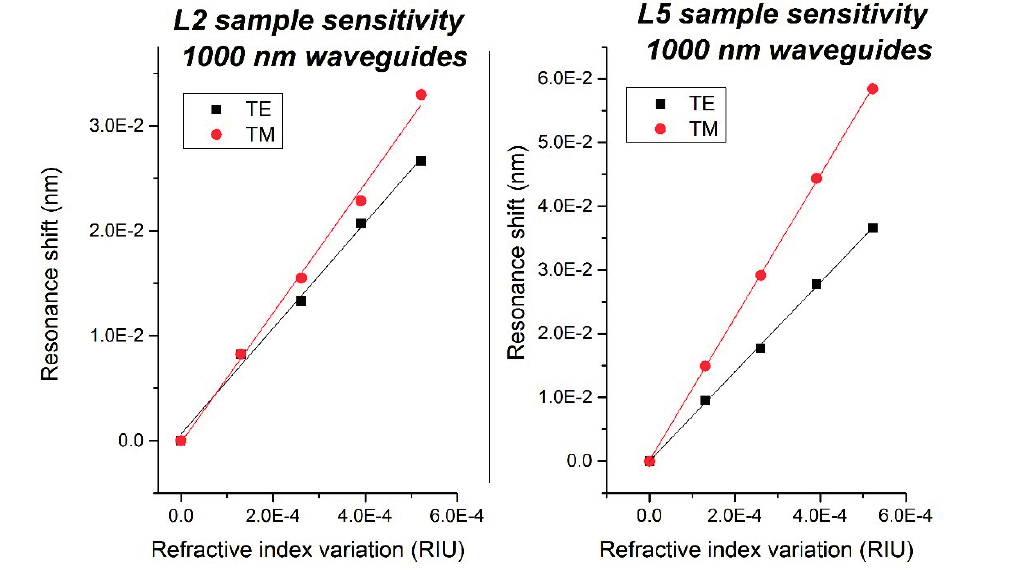
Figure 8. ( Left ) Sensitivity of the L2 sample; ( Right ) Sensitivity of the L5